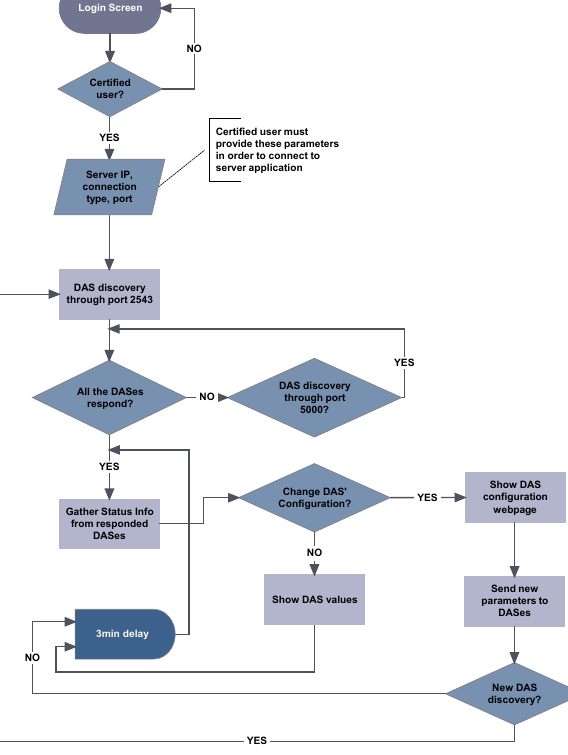
Fig. 6. Flow chart for controlling and monitoring HSNC’s remote stations by certified